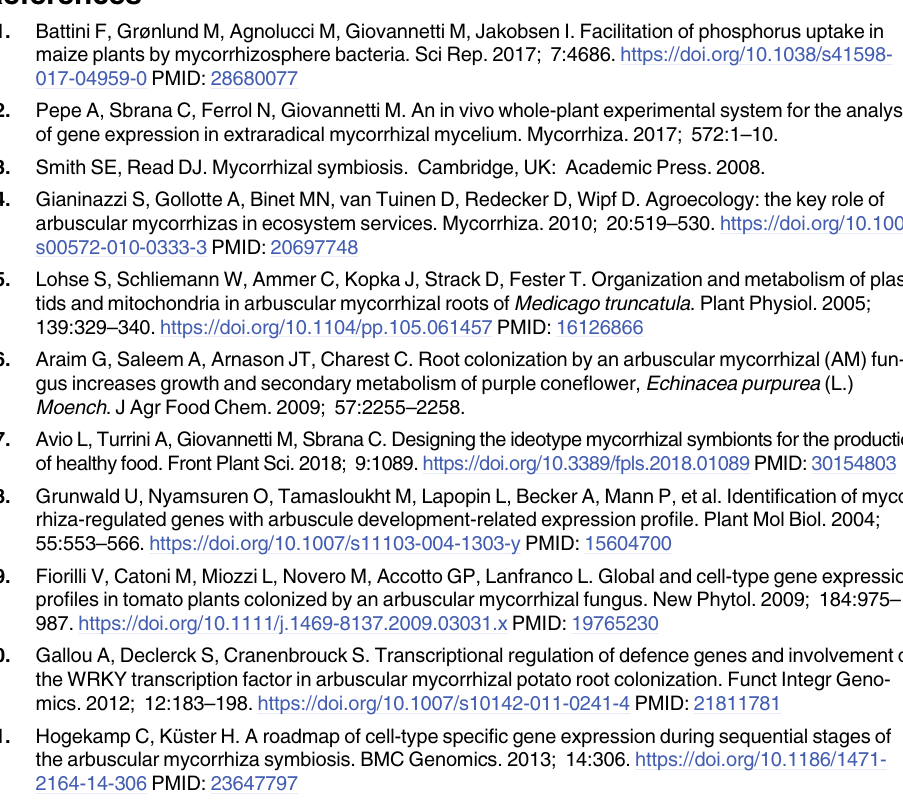
S1 Fig. Relationship between expression and average coverage of each of the 46 RT sequences expressed in mycorrhizal roots at 16 d after